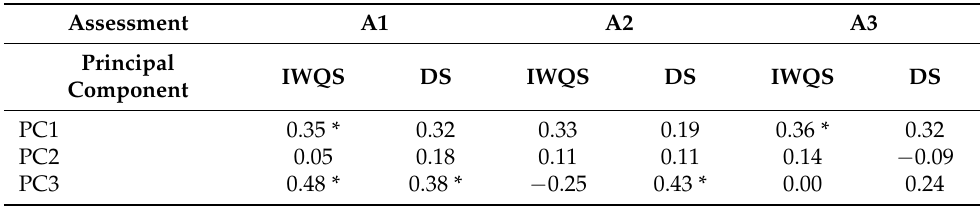
Table 7. Correlations between the first three principal components (PCs) and the IWQS and DS in the studied